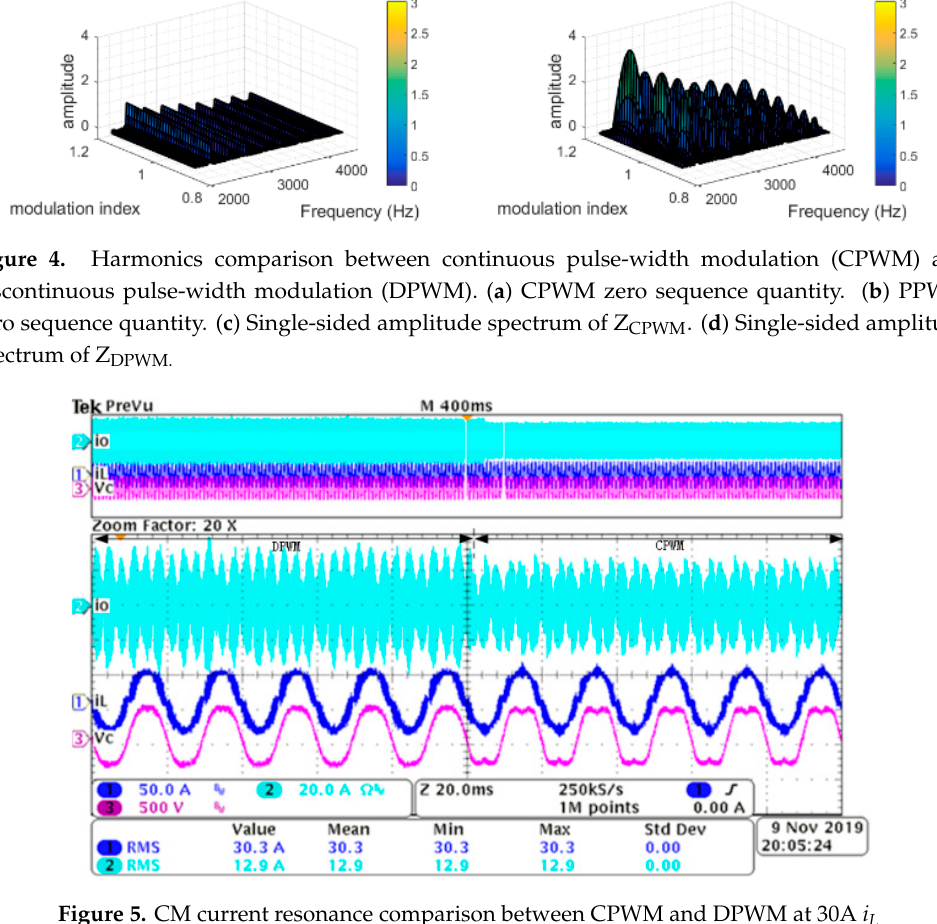
Figure 5. CM current resonance comparison between CPWM and DPWM at 30A i L.